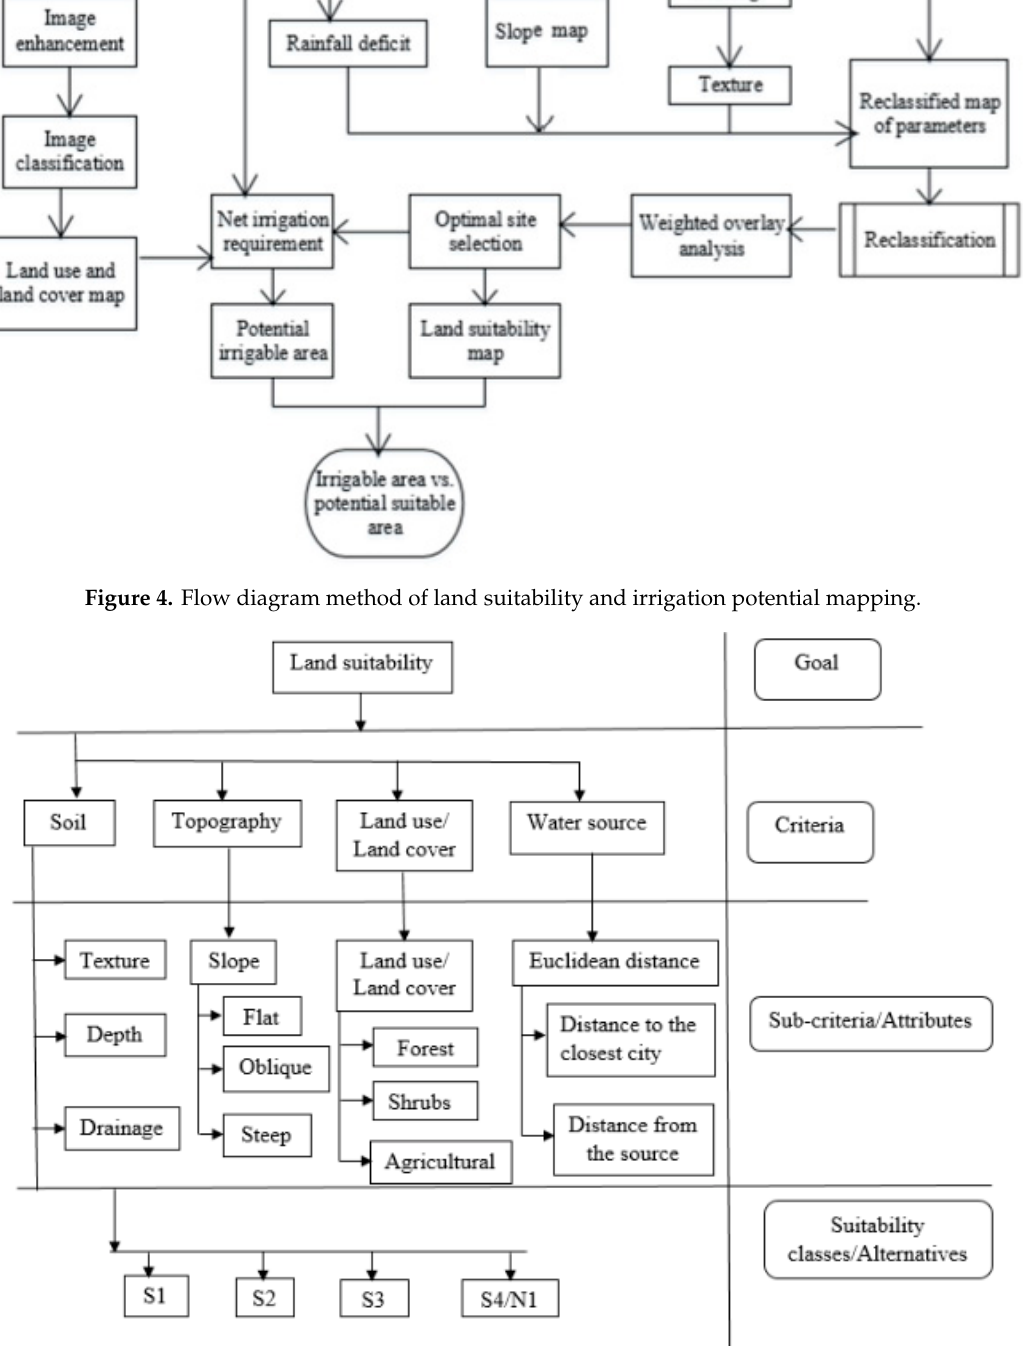
Figure 5. Hierarchical organization of criteria [60,61] .